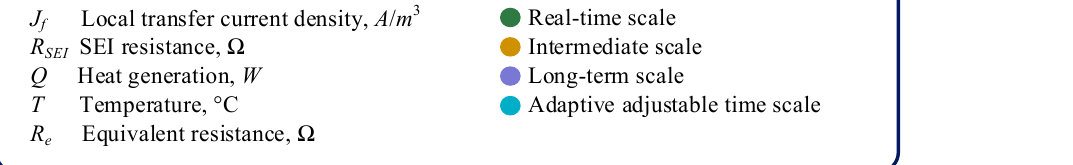
Figure 4. BMS-based battery SOC, SOH, RUL, SOF, SOP, SOE, and SOS estimation framework for EV applications.